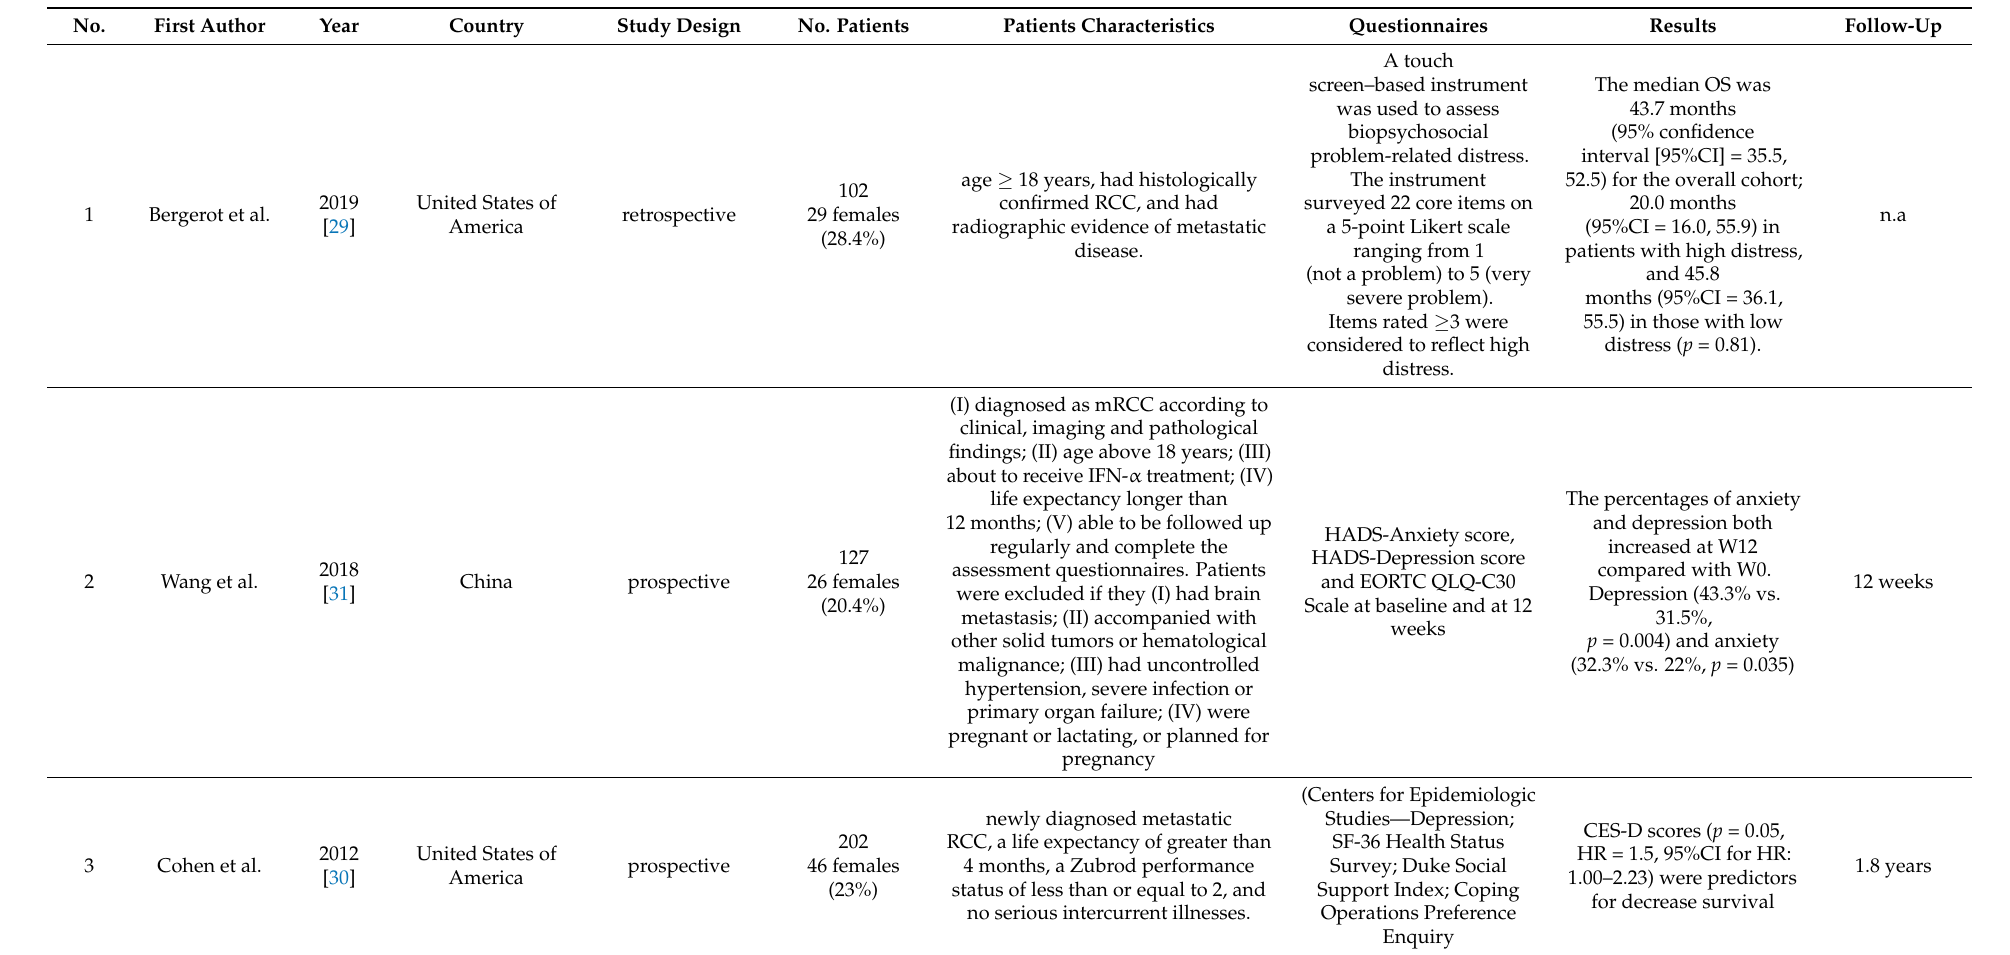
Table 3. Studies that assessed the impact of psychological distress, anxiety and/or depression on patients with metastatic renal cell carcinoma